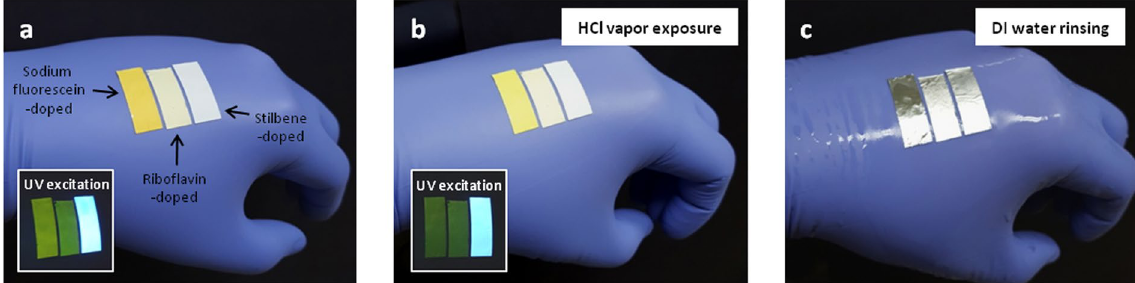
Figure 4. FSNs as disposable hazard indicators. ( a ) Rectangular pieces of FSNs attached on an experimental glove. ( b ) FSNs exposed to HCl fume. FSNs doped with sodium fluorescein only react to HCl exposure, while other FSNs doped with riboflavin or stilbene remain unchanged. ( c ) DI water rinsing to remove FSNs.